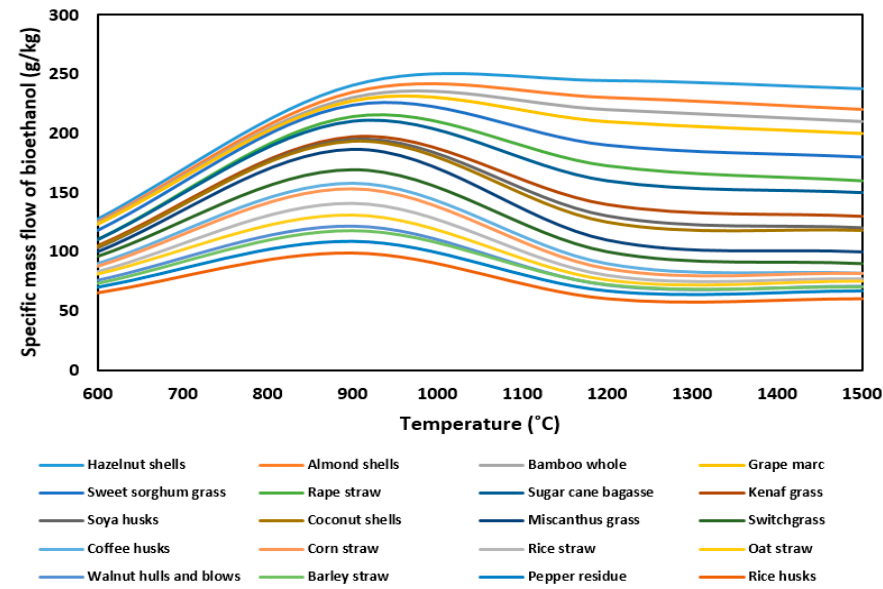
Figure 4. Effect of gasifier temperature on ethanol sm for 20 H&ABs.